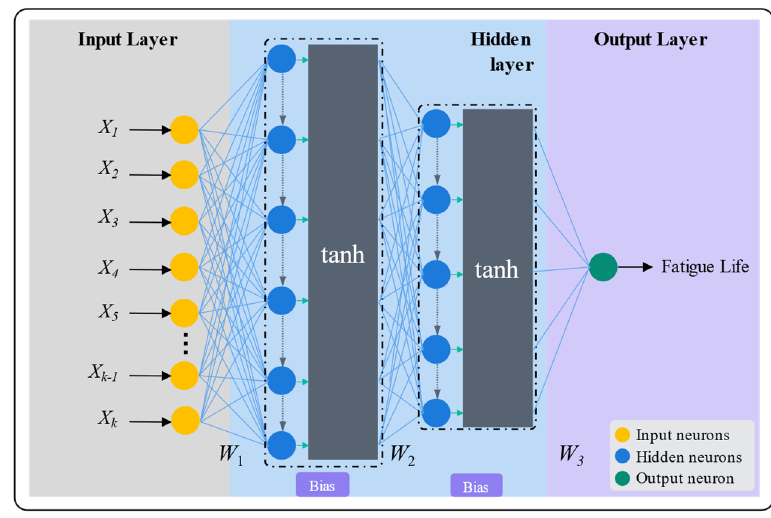
Figure 2. Schematic diagram of ANN model structure.